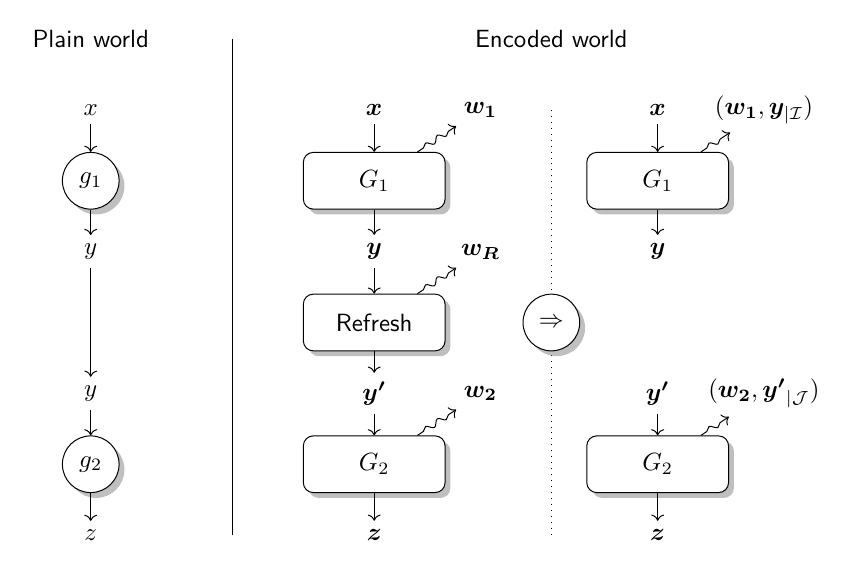
Figure 1: Illustration of the IOS